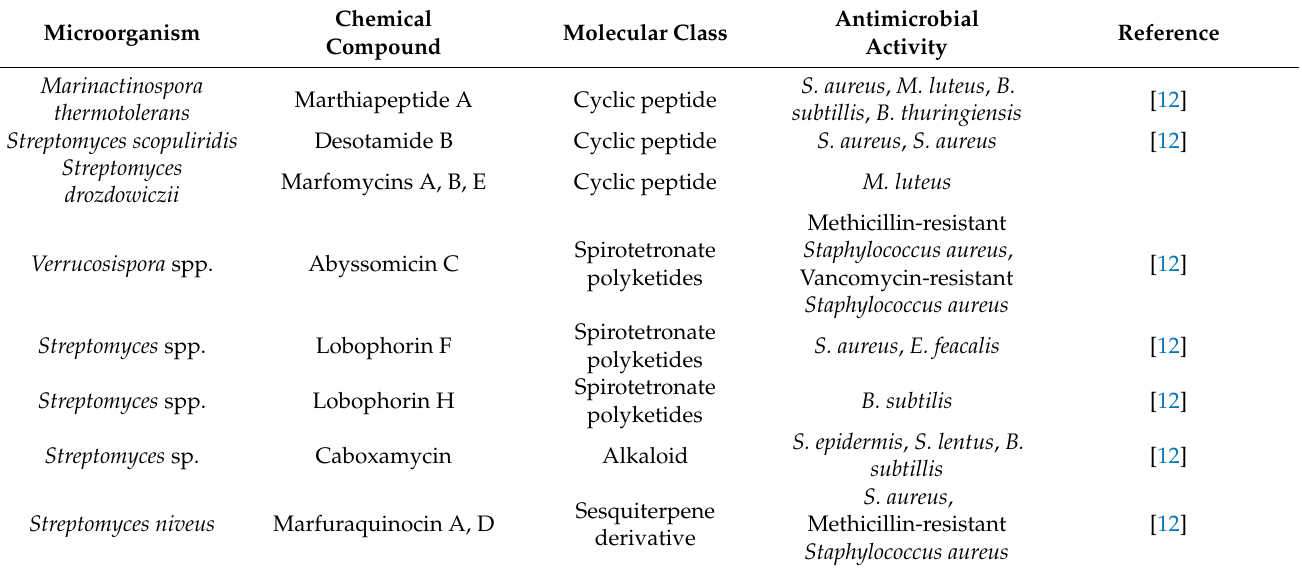
Table 1. Antimicrobial activity of chemical compounds isolated from